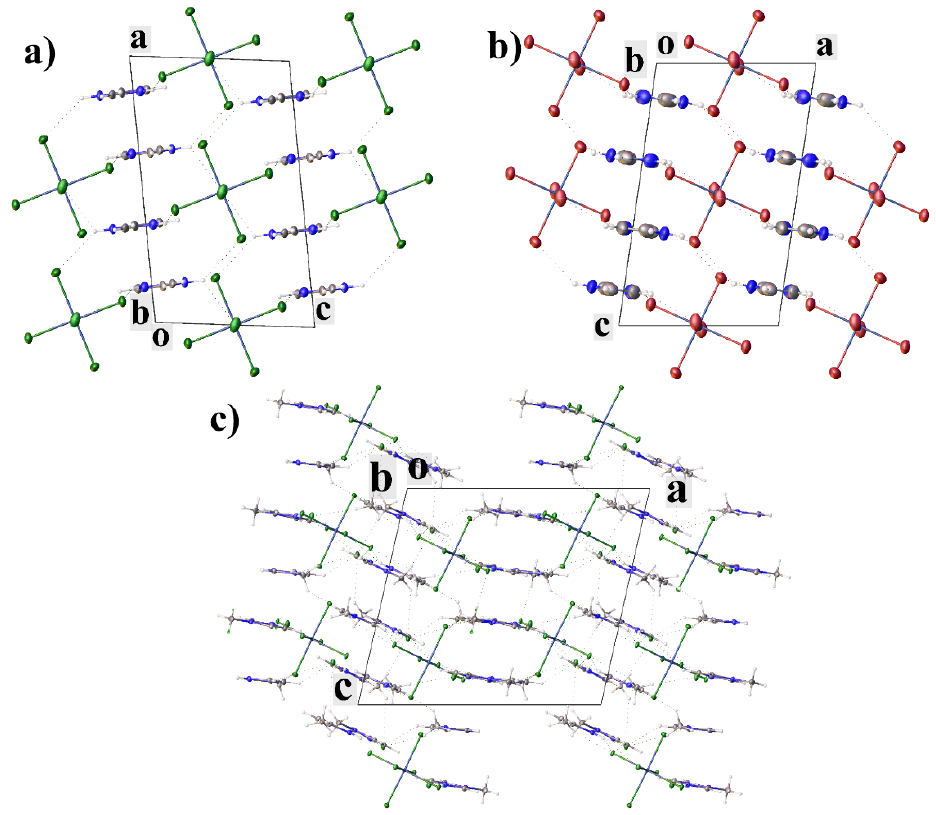
Figure 7. Crystal packing of VI (a) , VII (b) and VIII (c) , showing cation.